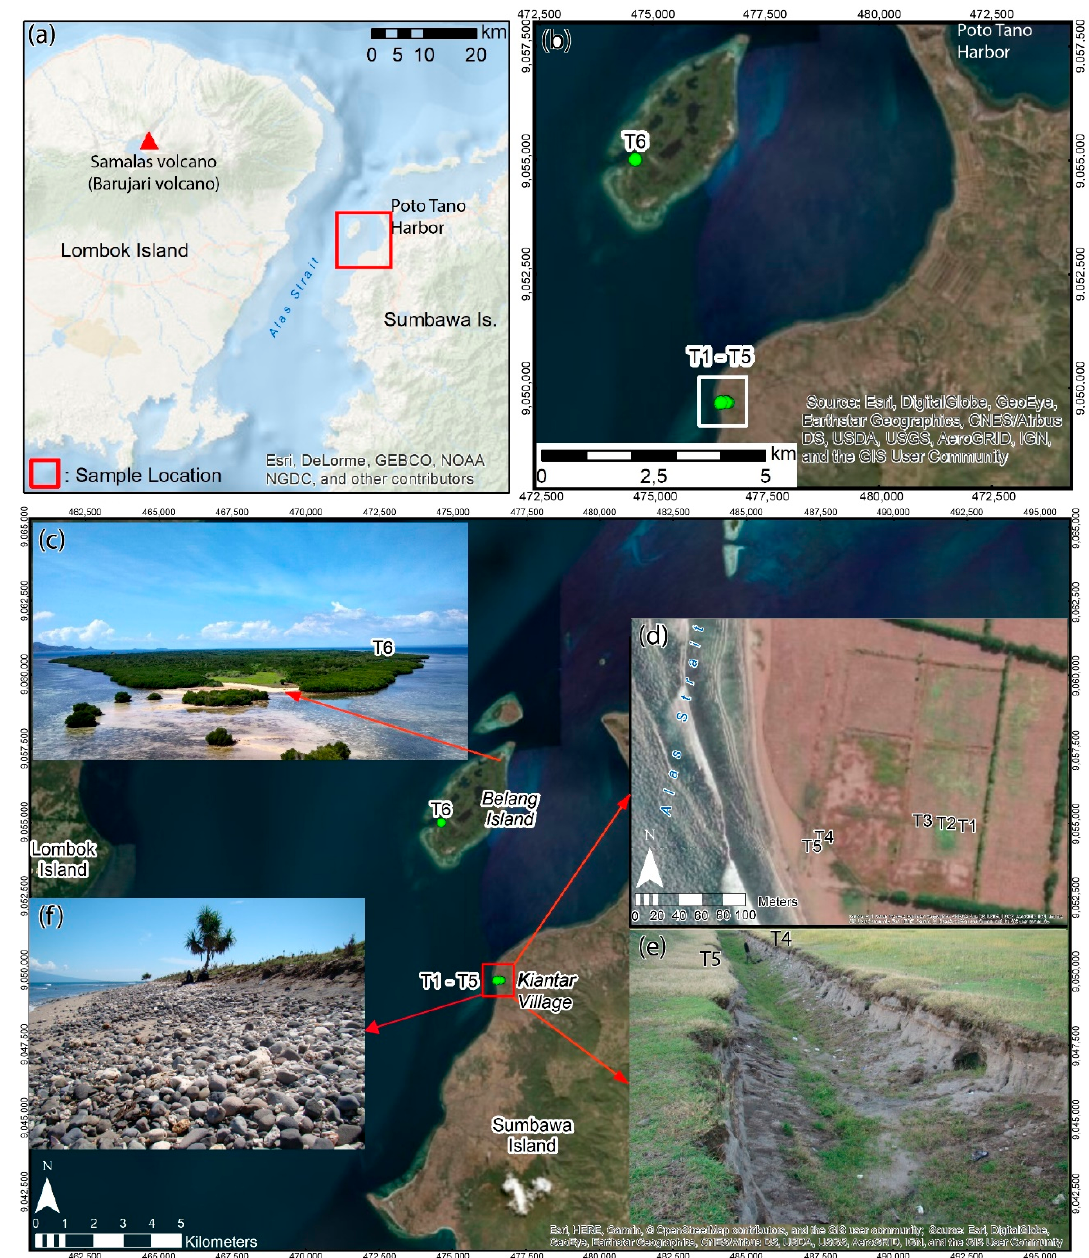
Figure 2. ( a ) The geographical situation of sample location in the context of Samalas volcano, Lombok, and Sumbawa Islands; ( b ) sample collection location in abandoned fishponds in Kiantar Village (T1–T5) and Belang Island (T6) on the western coast of West Sumbawa. Tsunami deposits in Belang Island and abandoned fishponds in Kiantar Village: ( c ) As a small uninhabited island located in Gili Balu conservation area on the western coast of Sumbawa, this island is dominated by mangrove ecosystems with several sandy areas; ( d ) sample collection location in abandoned fishponds in Kiantar Village; ( e ) abandoned fishponds in Kiantar Village with locations T4 and T5 sampling points as well as Alas Strait and Lombok Island to the west (left side); and ( f ) present-day beach materials that contain coarse rounded pebbles and coral debris.